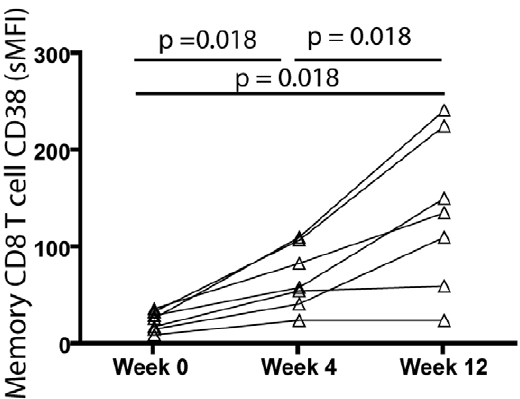
Figure 5. Therapeutic administration of IFN a induces increased expression of the activation marker CD38 on memory CD8 T cells in HCV-infected subjects. A longitudinal study was conducted to assess CD38 expression on memory (CD45RO + ) CD8 T cells. Seven HCV-infected (HIV-1-uninfected) subjects were studied immediately prior to initiation of therapy with s.c. pegylated IFN a and oral ribavirin, and after 4 and 12 weeks of therapy. CD38-specific MFI (MFI for CD38 minus MFI for IgG1 isotype control) increased on memory CD8 T cells in all seven treated subjects at 4 weeks of therapy (p=0.018). A further increase in CD38 was observed in five of seven subjects by week 12 of therapy (p=0.018). The difference in CD38 expression between week 0 (prior to therapy) and week 12 was highly significant